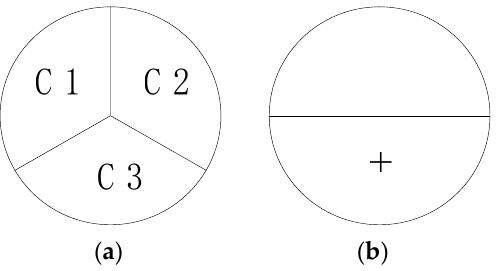
Figure 1. Electric motor whit 3 magnetic poles in stator, and 2 magnetic poles in rotor: ( a ) 3 magnetic poles stator; ( b ) 2 magnetic pole rotors.